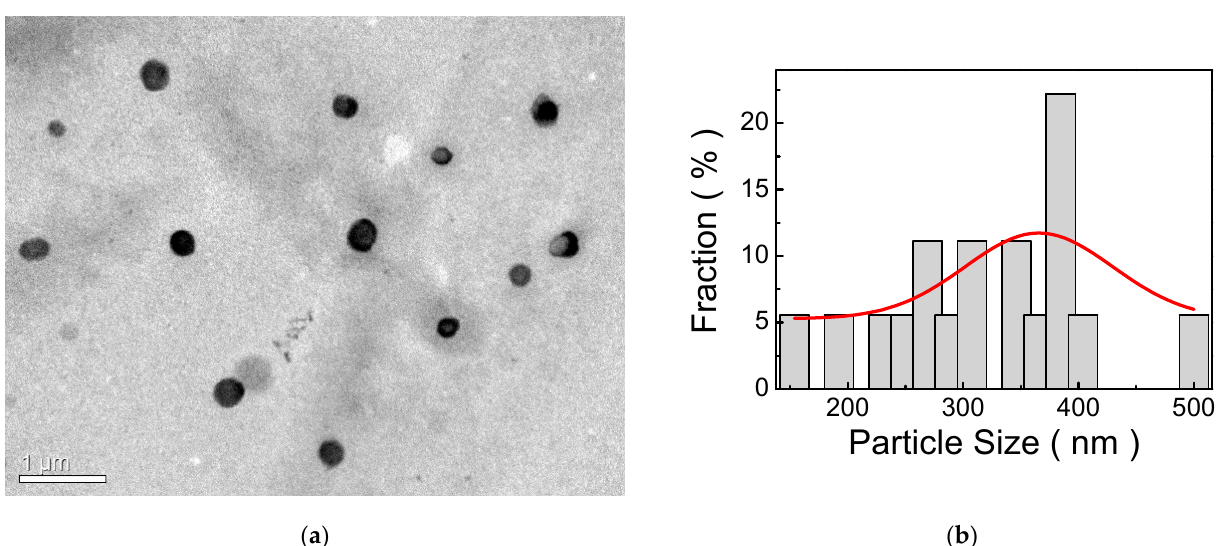
Figure 3. ( a ) TEM image of self-assembled nanoparticles; ( b ) The histogram of the size distribution of self-assembled nanoparticles.